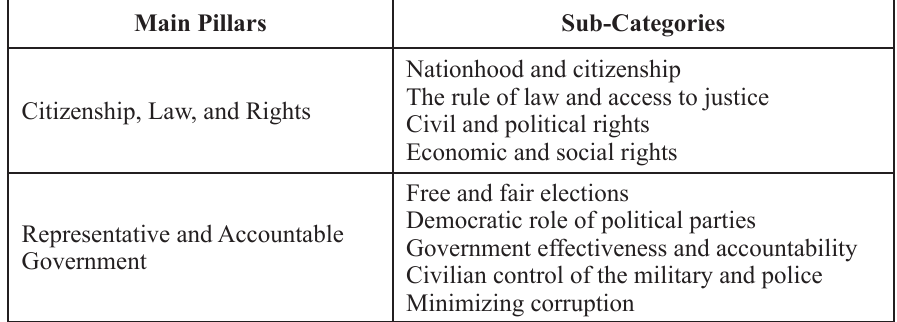
Table 1. Pillars and Sub-Categories of Democracy Assessment Main